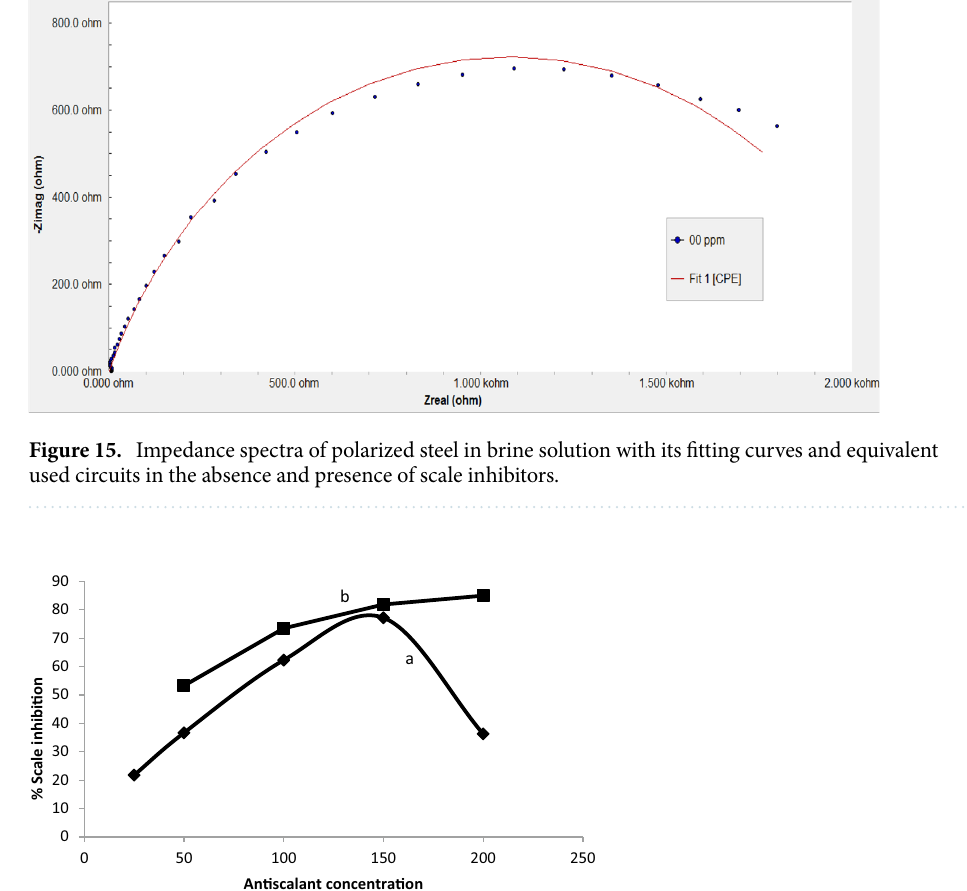
Figure 16. Variation of % CaCO 3 inhibition with different concentration of: ( a ) Copolymer 2 ( b ) Oxidation product of substrate 1 without addition of aniline initiator.